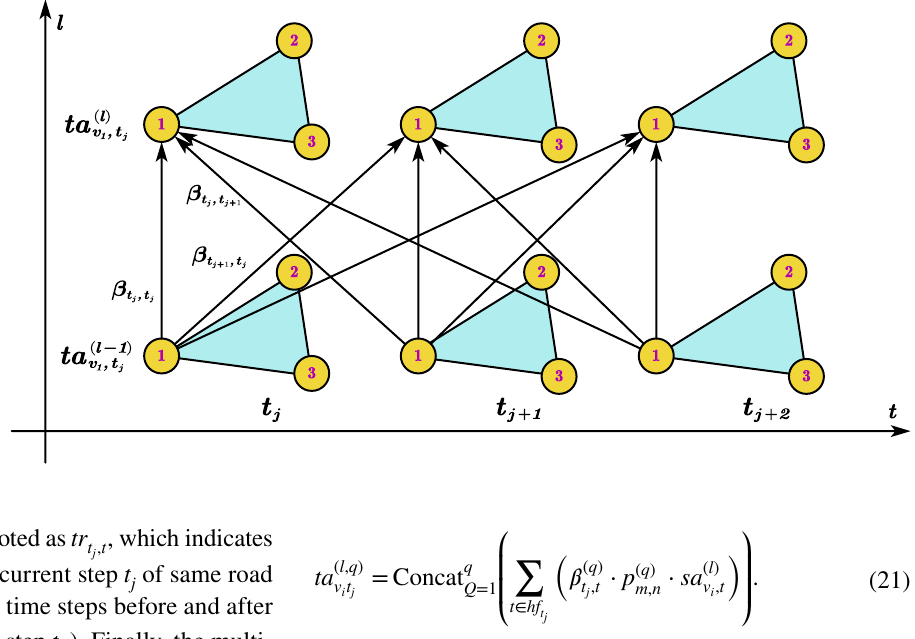
Fig. 4 Principle of temporal